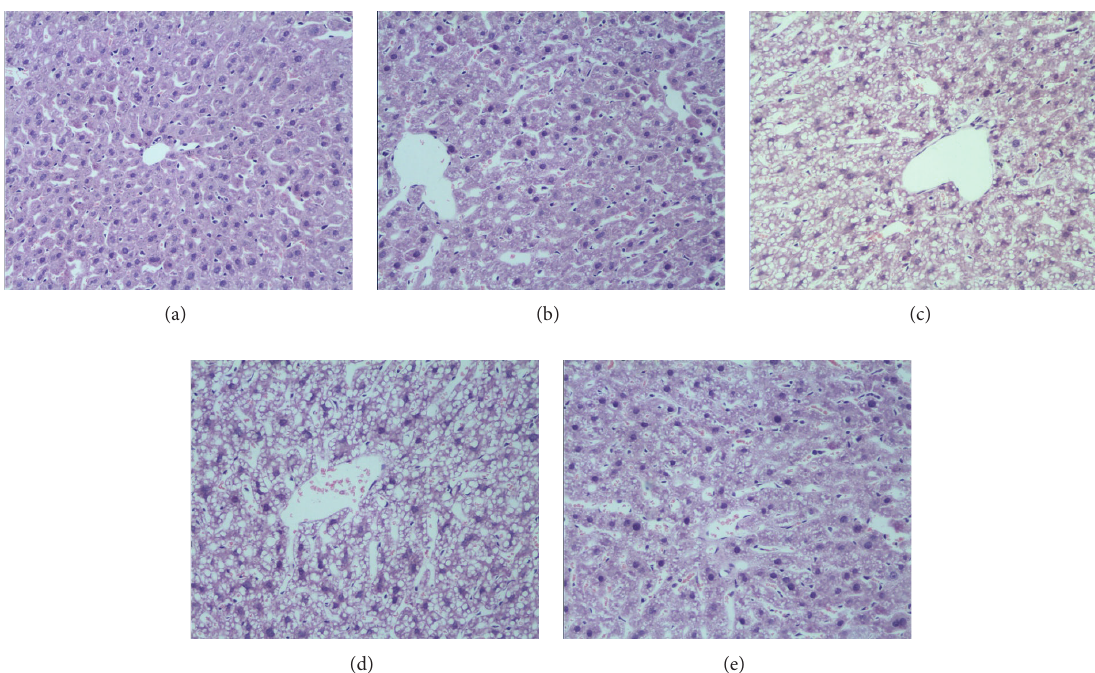
Figure 1: Hepatic pathology. Liver sections stained with hematoxylin and eosin from mice. (a) Control group, (b) ALD (4W) group, (c) ALD (8W) group, (d) ALD (12W) group, and (e) Anti-IL-17 antibody treated ALD group. Original magnification ×200 . Data are representative of three separate experiments.